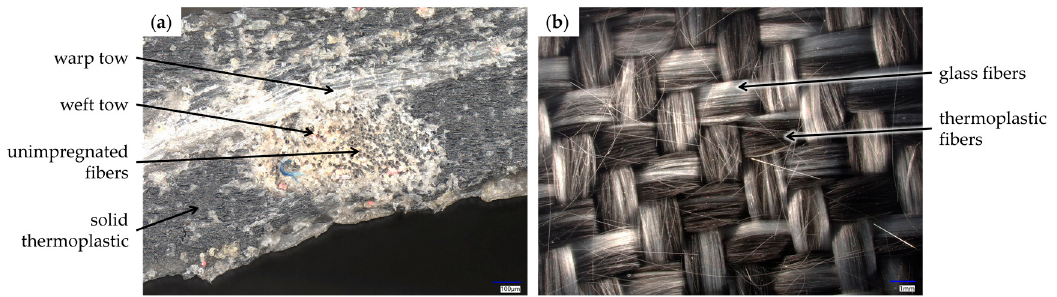
Figure 22. ( a ) Microscope image of cross section cut in locally hot-pressed thermoplastic commingled yarn fabric; ( b ) Microscope image of untreated surface of commingled yarn fabric.